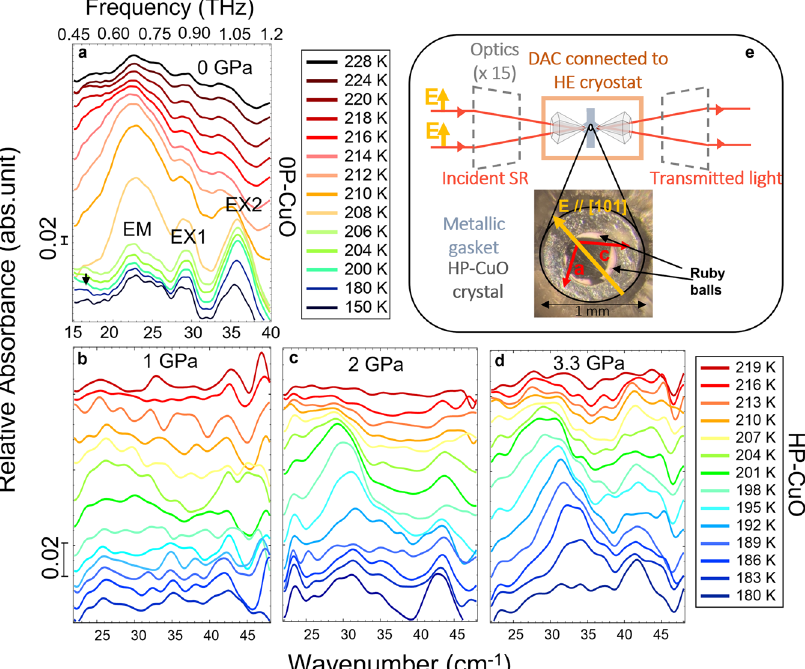
Fig. 1 THz absorbance of CuO electromagnons excited with E ω ∥ [101] under hydrostatic pressure. a Relative absorbance spectra of a mm- thick CuO sample (0P-CuO) measured for several temperatures at zero pressure. b – d Relative absorbance spectra measured for several temperatures and pressures on a 60 μ m-thick sample placed inside a pressure cell (HP-CuO). The reference spectra used to calculate the absorbance are the transmission spectrum measured at high temperature (250 K) in the same conditions of pressure and alignment. The spectra are shifted in the vertical direction, but the relative intensities of absorbance are preserved, as represented by the 0.02 absorbance unit bar on bottom left corner of each graph. The spectra obtained at 0.3 GPa are reported in the supplementary Fig. 2. e Represents a schematic of the experiment with an image of the HP-CuO sample in the pressure cell and the orientation of its axes. The scale bar represents